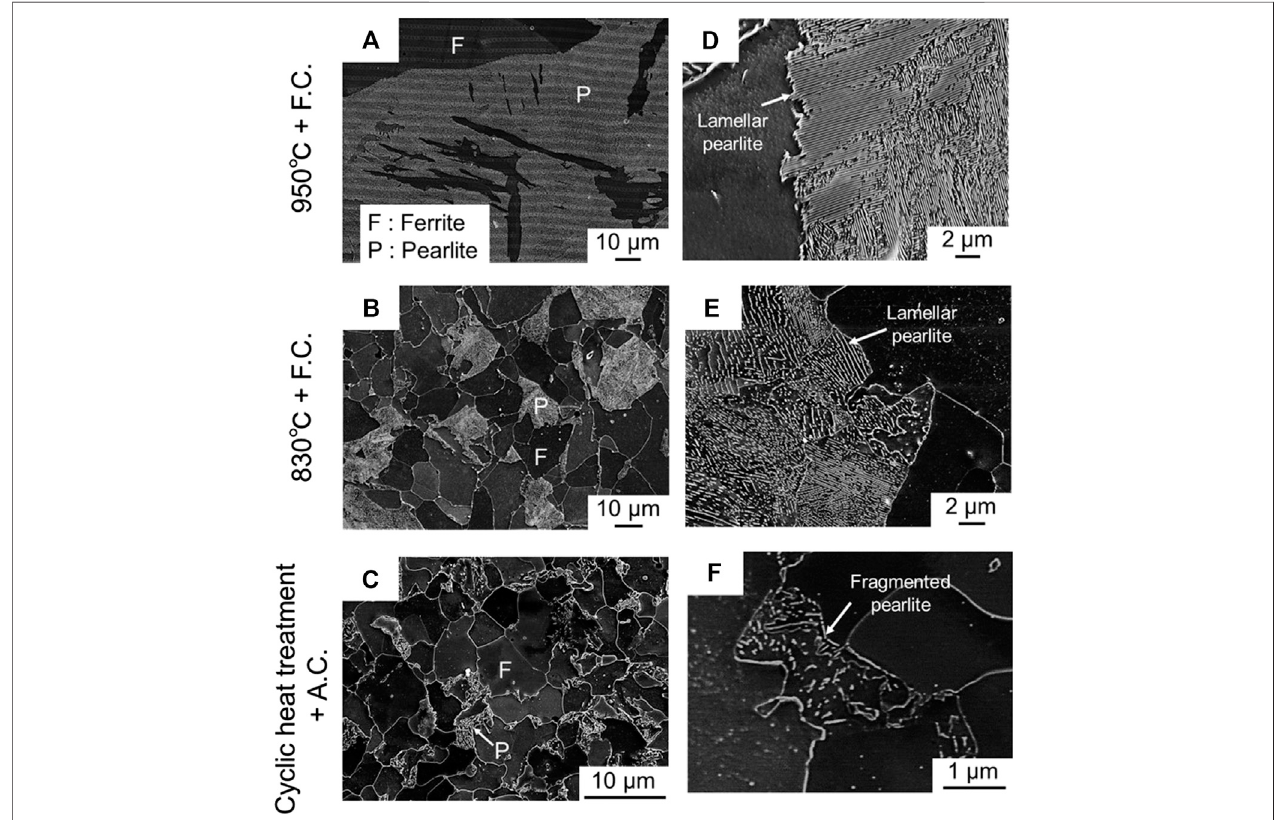
FIGURE 8 | SEM microstructures of the specimens with ferrite + pearlite (F + P) microstructures simply austenitized at (A, D) 950 ° C or (B, E) 830 ° C followed by furnace-cooling,and (C,F) theF+Pspecimencyclicheat-treatedat810 ° Cuptofourcyclesfollowedbyair-cooling. (A – C) lowermagni fi cationimages,and (D – F) higher magni fi cation